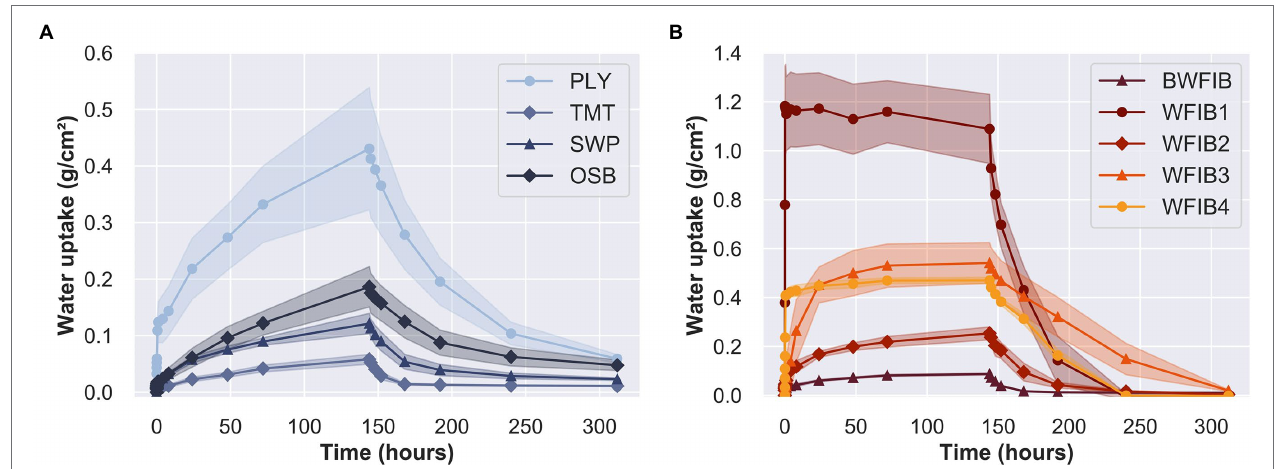
FIGURE 8 | Mean liquid water uptake (g/cm 2 ) with standard deviation over 144 h of absorption and 168 h of desorption in a floating test. (A) Wood-based panels: radiata pine plywood (PLY), thermally modified spruce (TMT), three-layer spruce panel (SWP) and oriented strand board (OSB); (B) Insulation materials: bituminised wood fibre board (BWFIB) and wood fibre insulation type 1–4